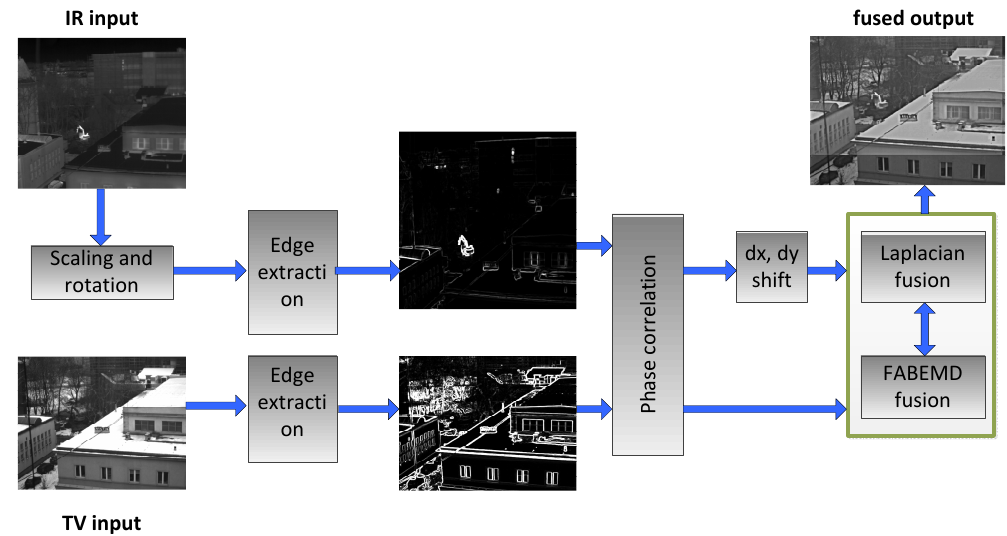
Figure 37. Video data processing flow implemented in the